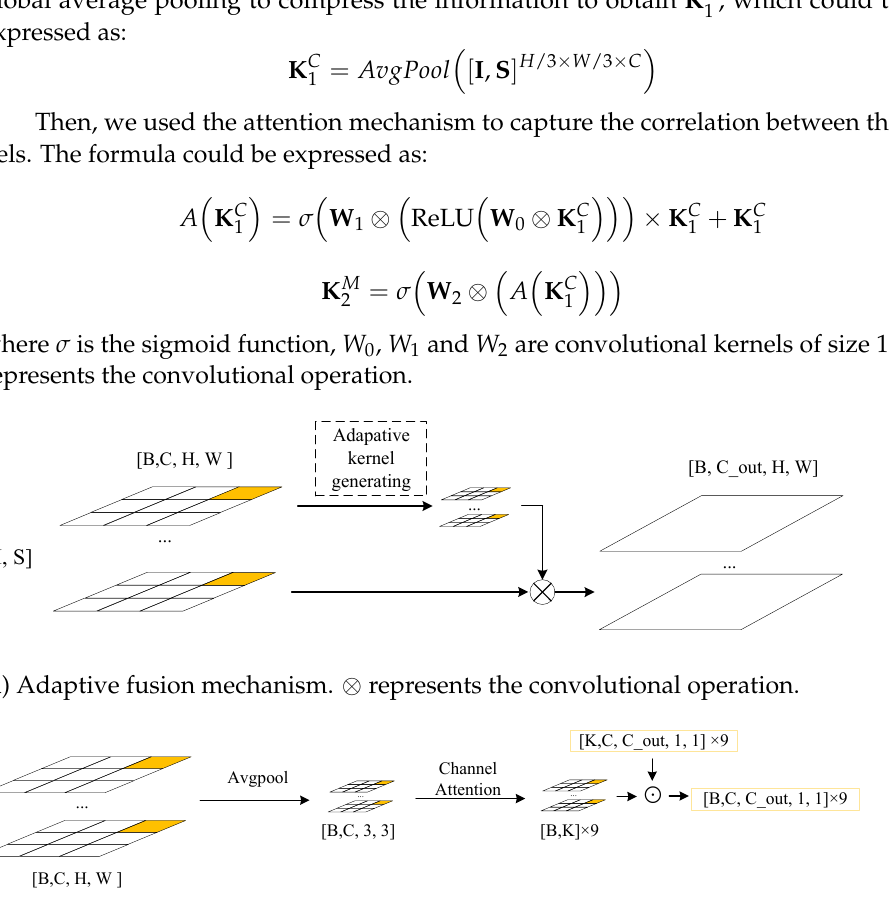
Figure 1. The adaptive fusion mechanism: ( a ) the overall flow of our adaptive fusion mechanism (for image feature I and depth map feature S , the adaptive kernel mechanism dynamically generates a kernel K G to fuse I and S and outputs the new depth feature D ); ( b ) the adaptive kernel